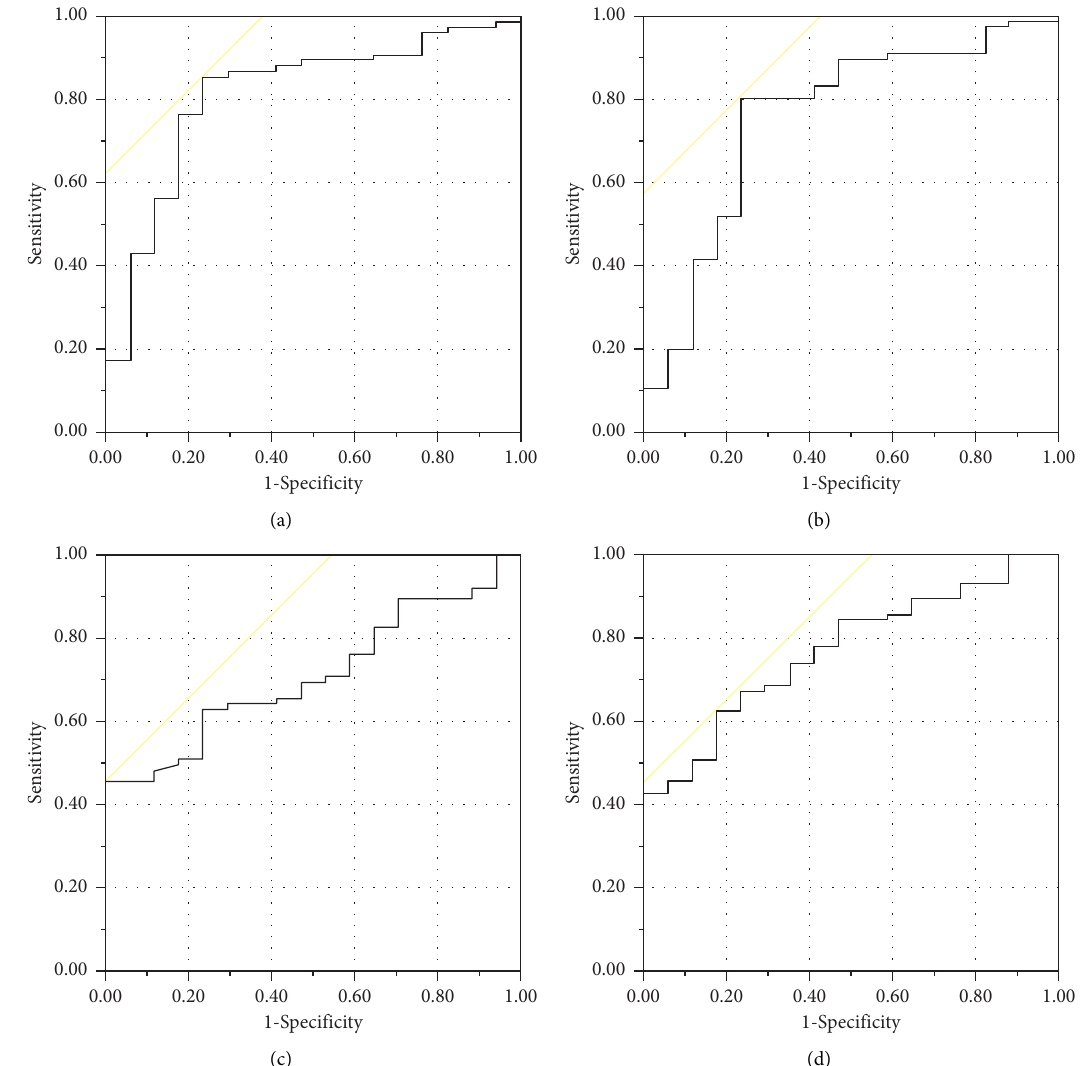
Figure 3: Receiver operating characteristic curves for neutrophil lymphocyte ratio (NLR) and monocyte lymphocyte ratio (MLR). (a) NLR of POD1. Sensitivity, 0.85; 1 − specificity, 0.24; and area under the curve, 0.81. (b) NLR of POD7. Sensitivity, 0.81; 1 − specificity, 0.24; and area under the curve, 0.76. (c) MLR of POD1. Sensitivity, 0.45; 1 − specificity, 0.00; and area under the curve, 0.71. (d) MLR of POD7. Sensitivity, 0.62; 1 − specificity, 0.18; and area under the curve,